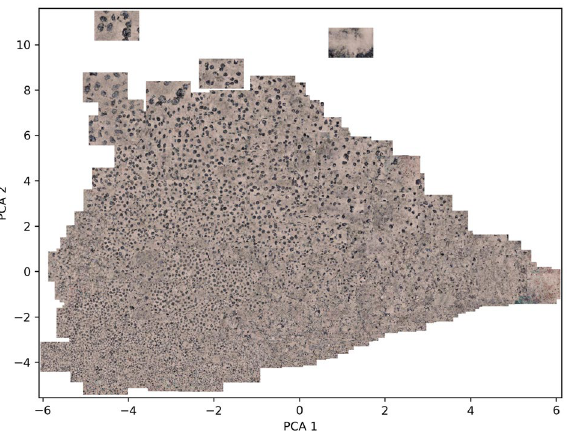
Figure 8. PCA projection of all images onto feature space without color coding. Semantically similar images (e.g., those with large Mn-nodules) can be seen to group